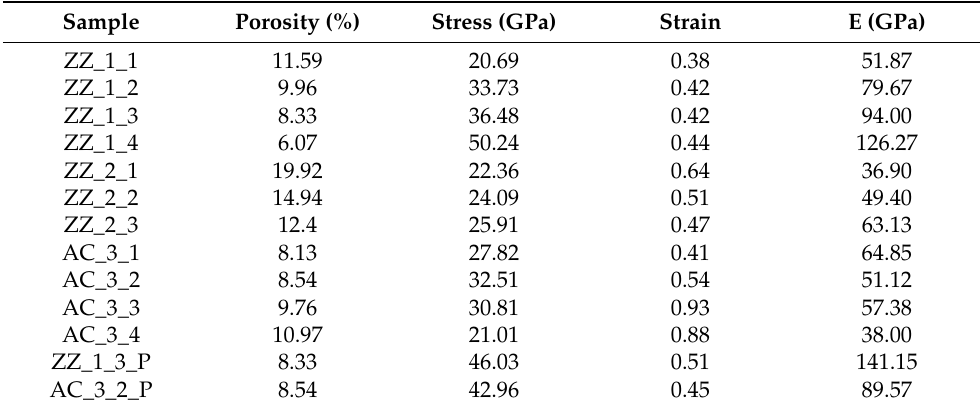
Table 2. Measured shear properties of the GK membranes based on MD